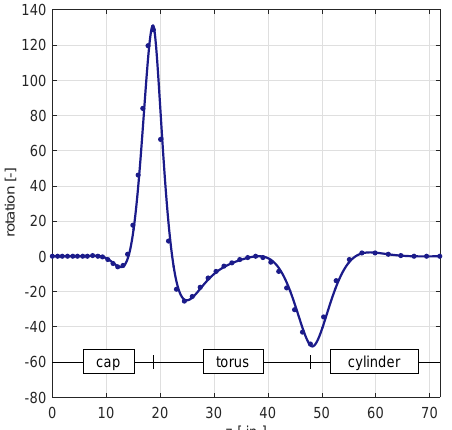
Figure 17. Torispherical tank subject to uniform internal pressure. Rotation β 1 solid blue line - present approach vs. blue bullets - reference solution